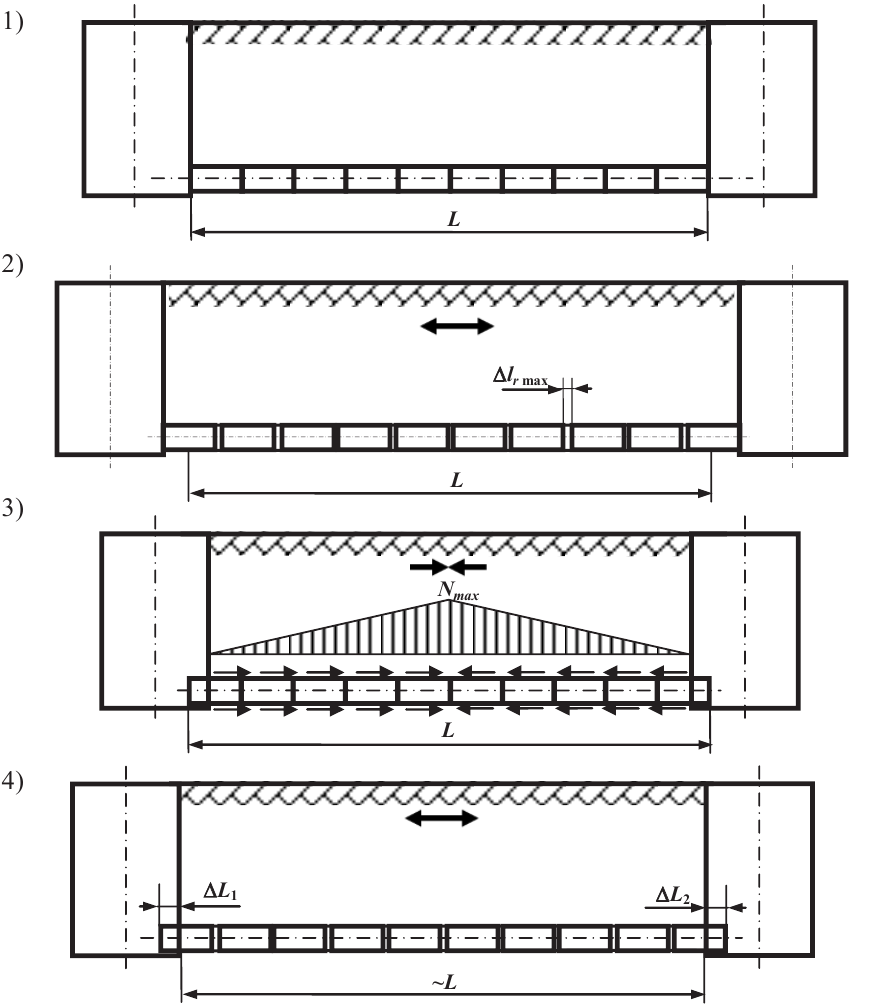
Fig. 3. Pipeline section built with the pipe jacking method: 1) initial state, 2) after soil loosening, 3) after soil compaction, 4) pipeline which was subjected to the mining influence